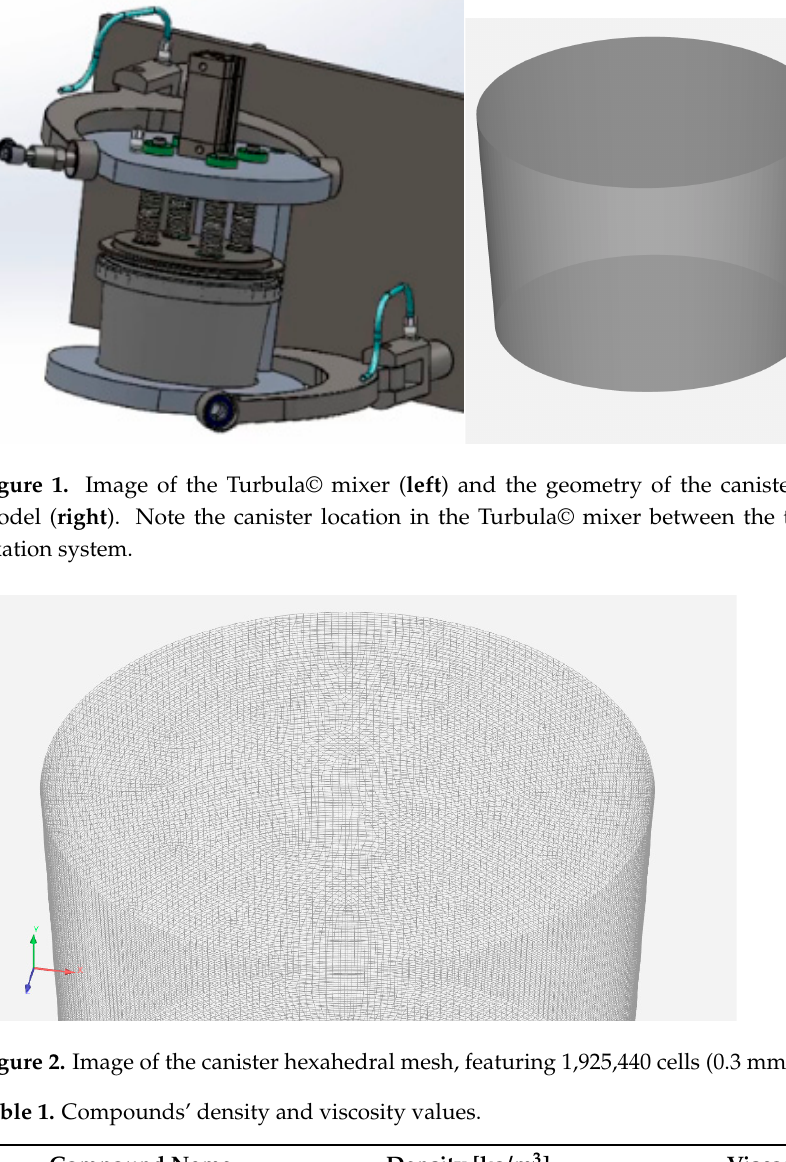
Figure 2. Image of the canister hexahedral mesh, featuring 1,925,440 cells (0.3 mm 3 /cell). Table 1. Compounds’ density and viscosity values.